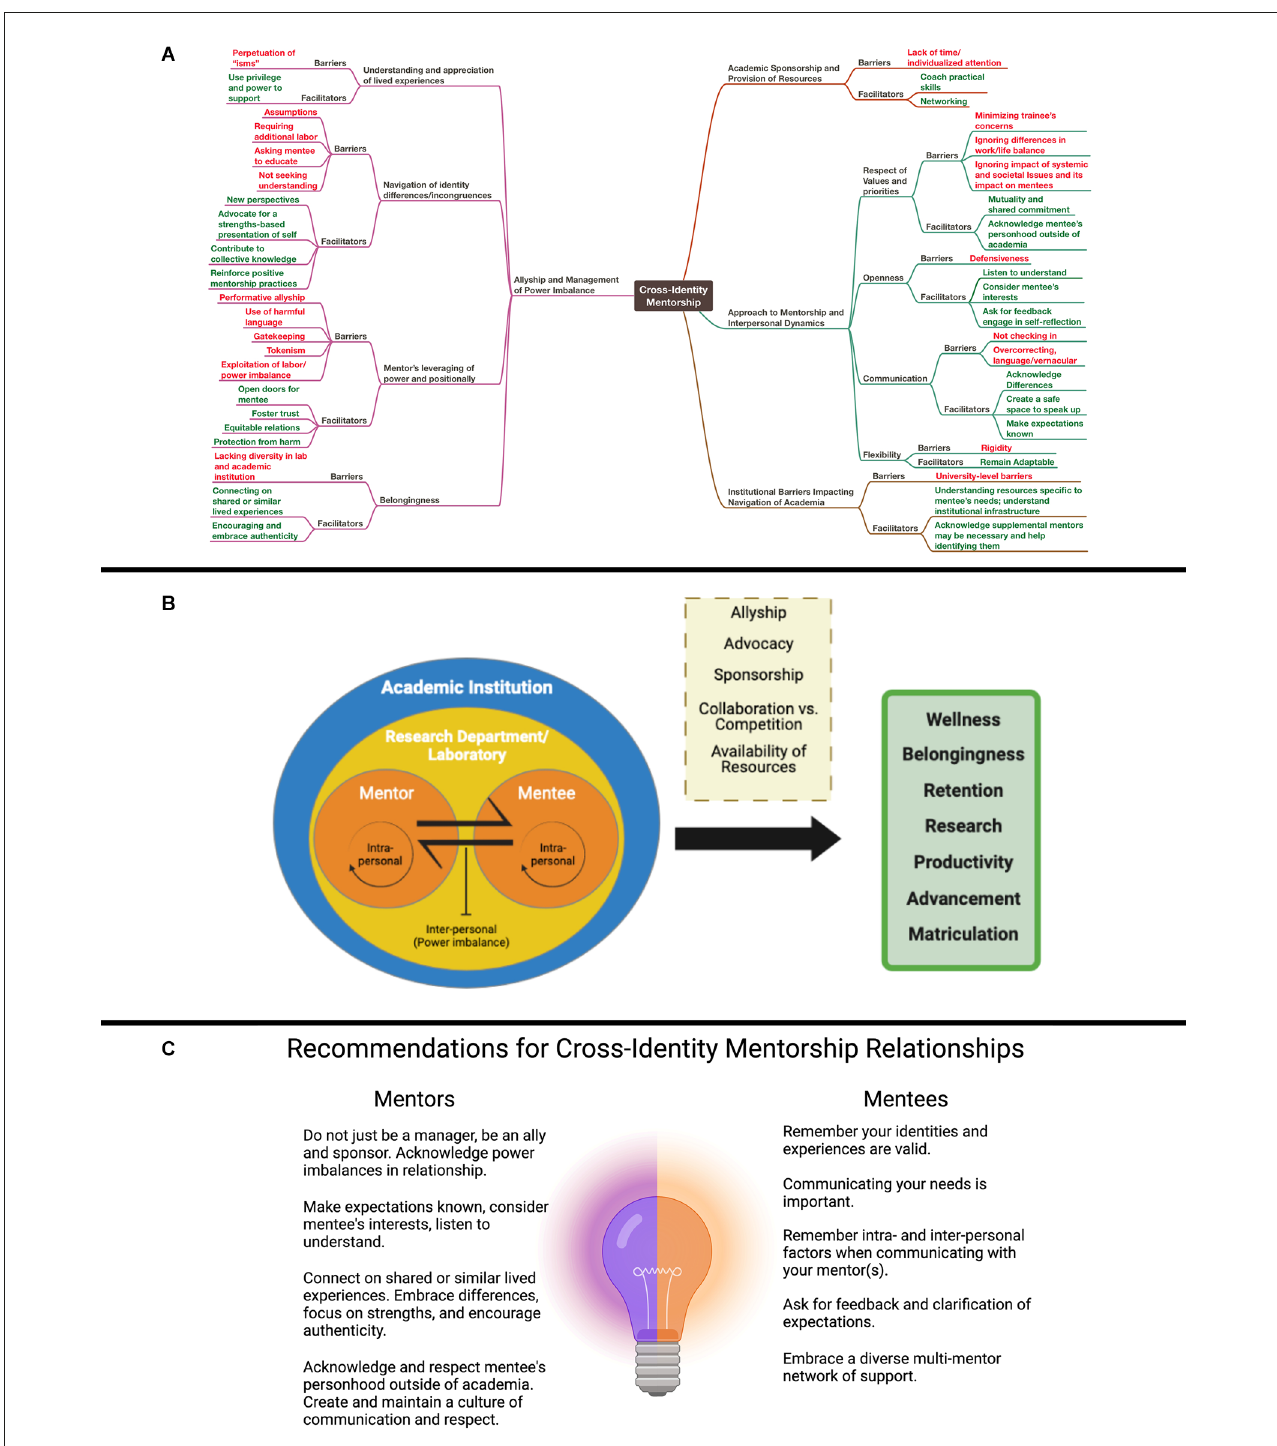
FIGURE1 Factors related to cross-identity mentorship in the neurosciences. (A) A thematic map of barriers and facilitators in cross-identity mentor-mentee relationships. A full description with participant quotes is included in the Supplementary Table . (B) Factors impacting cross-identity mentor-mentee relationships depend on a number of layered structural, local, intra- and interpersonal factors, but are all important for the wellbeing, productivity, and success of mentees. (C) Recommendations for mentors and mentees that emerged from the early career neuroscientist survey.